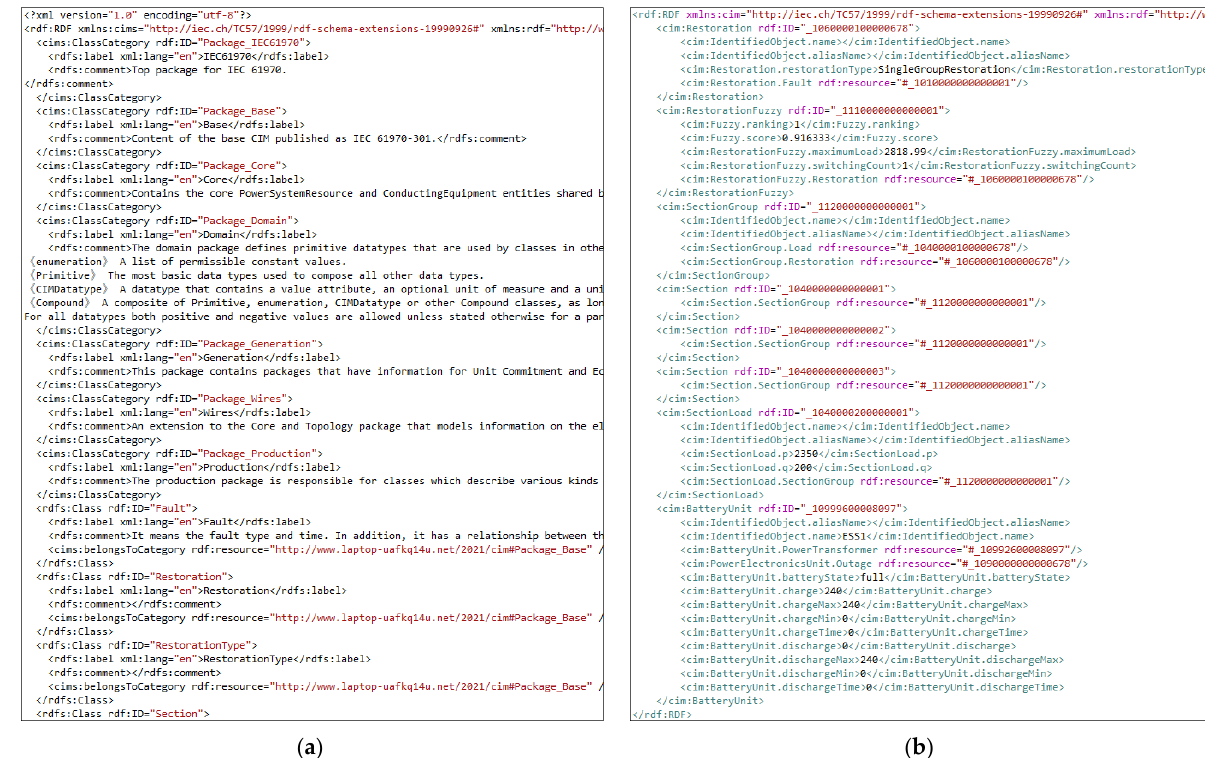
Figure 16. A UML diagram of the service restoration plan using the ESS.